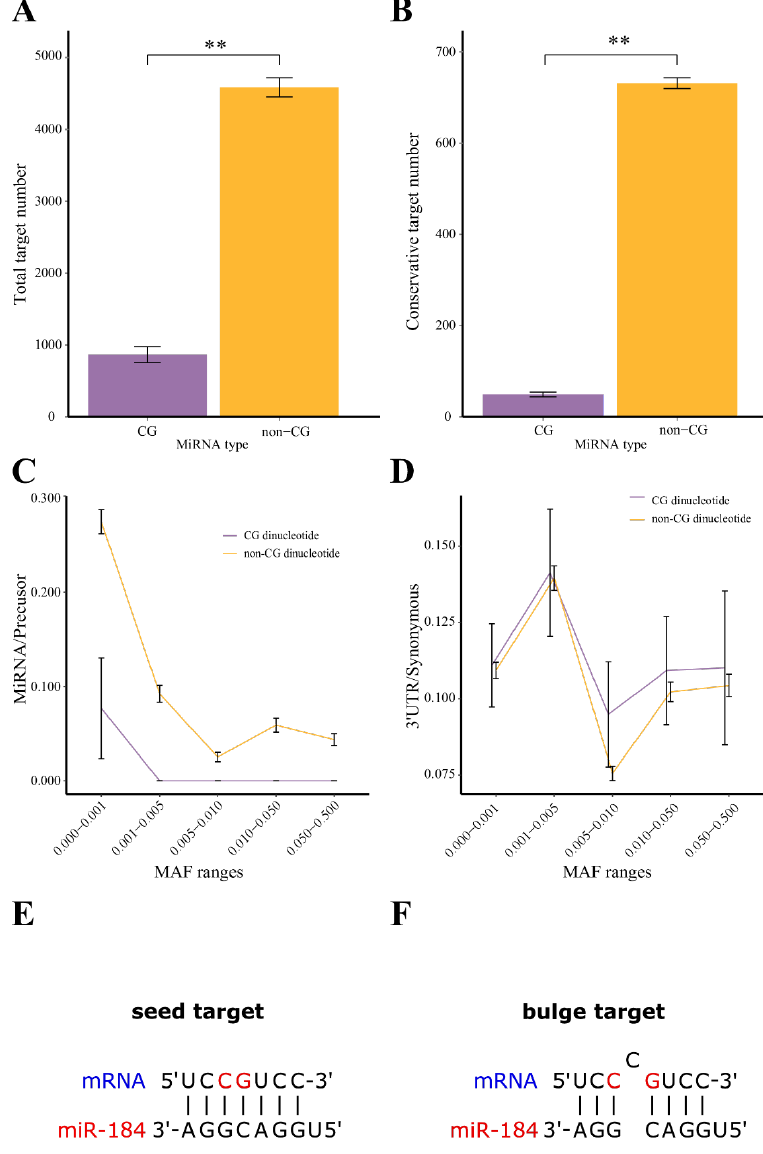
Figure 1. The CG dimer miRNAs have fewer conservative canonical targets than the miRNAs without CG dimer. ( A ) The number of target genes found by TargetScan for miRNAs with CG dimer at seed region or miRNAs without CG dimer. ** p < 0.001. ( B ) The number of conservative target genes found by TargetScan for miRNAs with CG dimer or miRNAs without CG dimer. ** p < 0.001. ( C ) The mutation rate of CG dimer in miRNA. The x axis is the MAF range and the y axis is the normalized number of mutations. Accumulation of miRNA mutations were normalized by the number of synonymous mutations and the length of the nearby gene. The CG dimer miRNAs group (purple line) and non-CG miRNAs group (orange line). The y axis scale is multiplied by 1000. ( D )